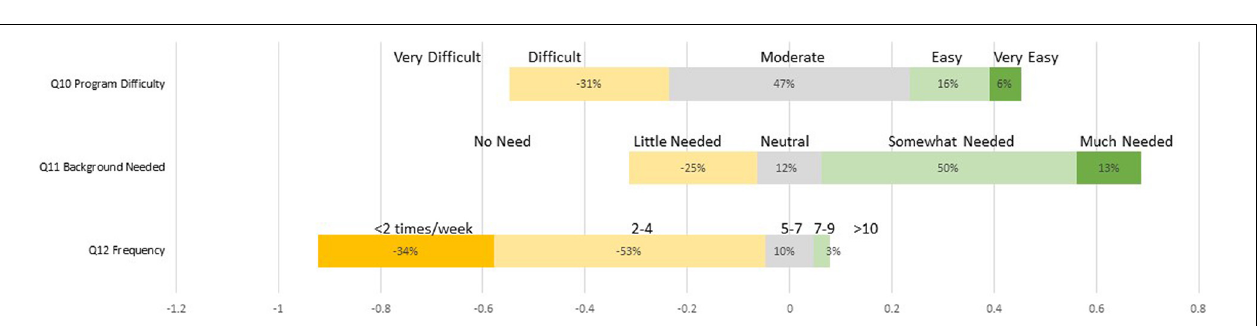
FIGURE 2 | The percentage of ratings on item 10 to item 12 in program evaluation